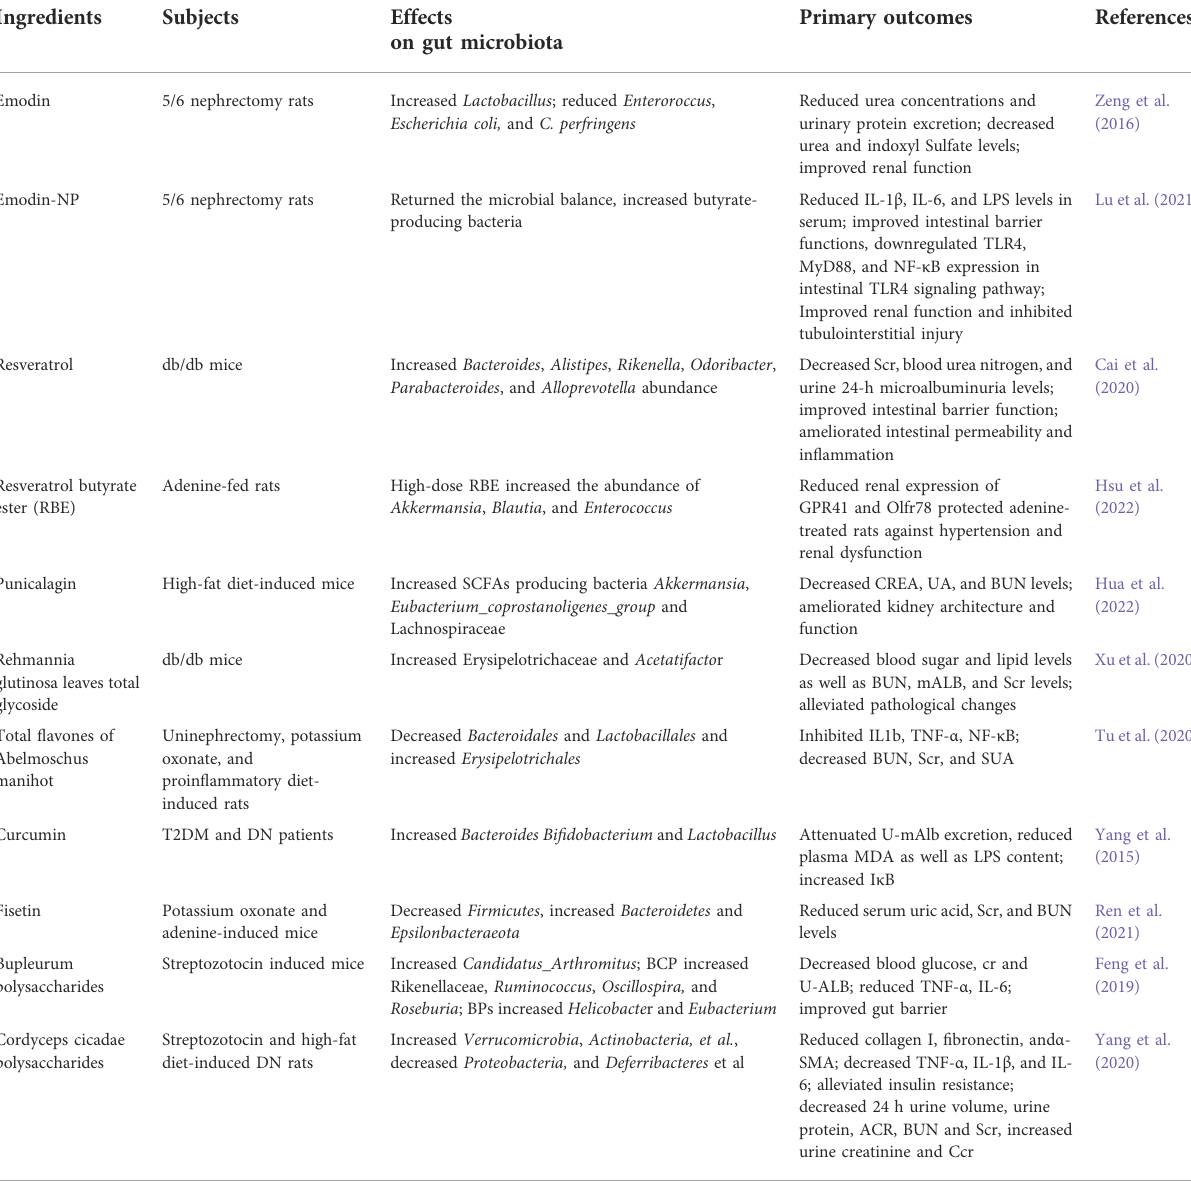
TABLE 2 Summary of the effects of natural extracts on gut microbiota and laboratory